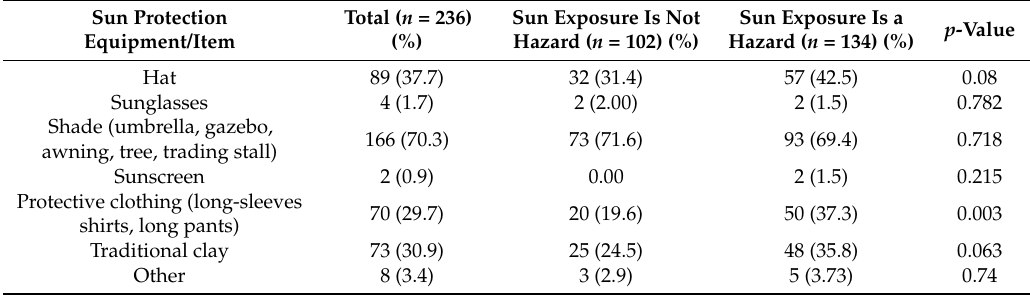
Table 4. The relationship between whether a participant agreed that sun exposure is a hazard and the use of sun-protective